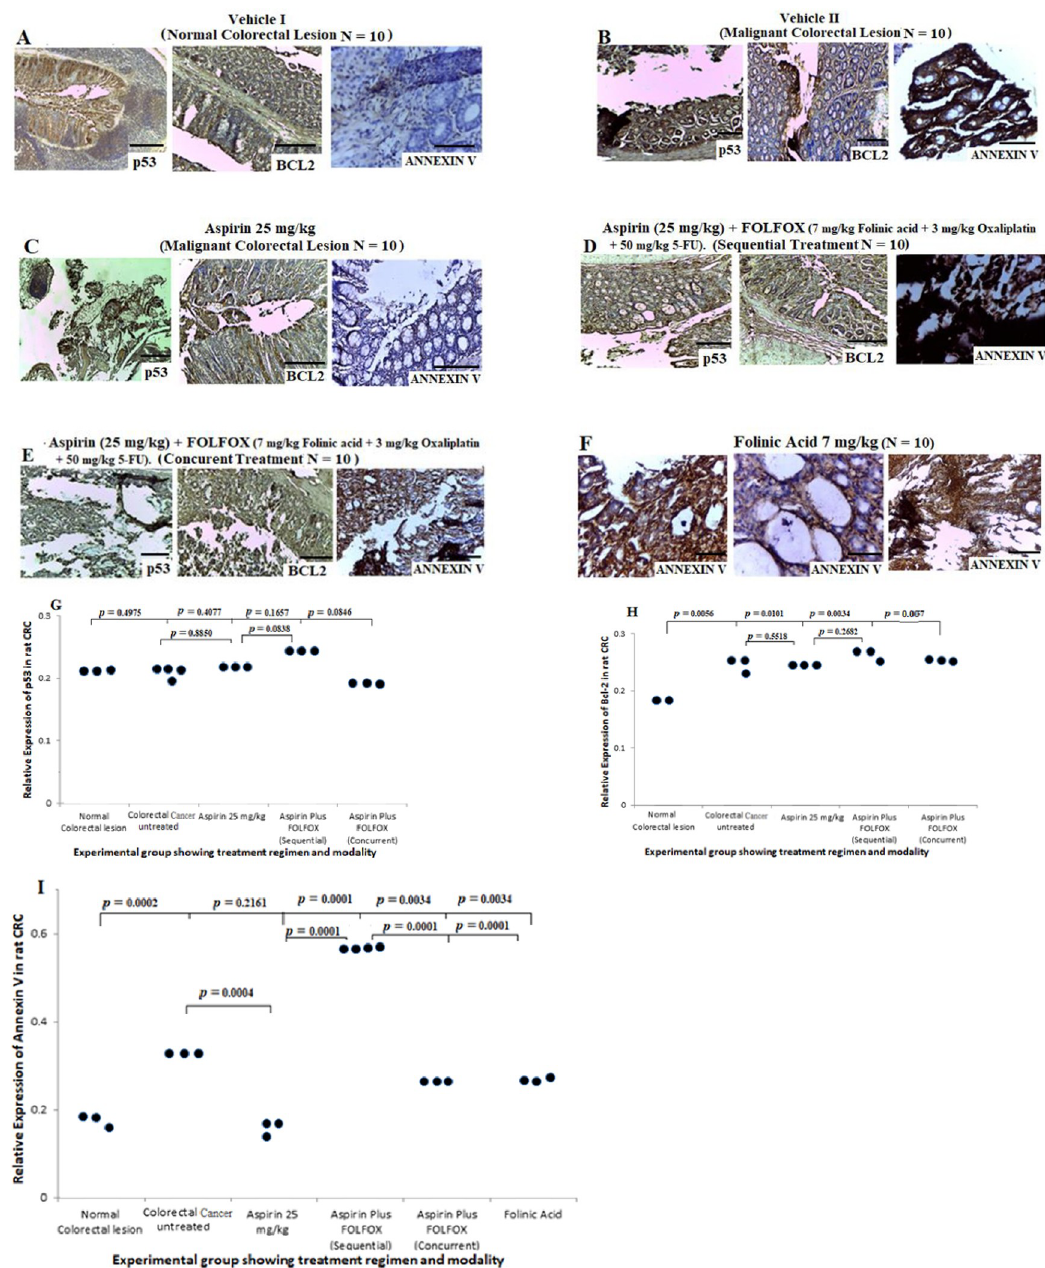
Fig 7. Prognostic significance of p53, Bcl-2 and Annexin V in colorectal cancer cells post-treatment with FOLFOX with or without aspirin in rat (scale bar = 50 μ m for H&E and scale bar = 100 μ m for IHC). A) Show positive expression of p53 and Bcl- 2 and negative expression of Annexin V in normal colorectal sections. B to F), Show positive expression of p53, Bcl-2 and Annexin V in colorectal cancer sections pre and post-treatment with 25 mg/kg aspirin, aspirin plus FOLFOX in sequence, aspirin plus FOLFOX concurrent, and folinic acid treatment. G to I) Quantitative analysis of the p53, Bcl-2 and Annexin V from the rats showing expression pattern typified in dot plot post and pre-treatment with aspirin and aspirin plus FOLFOX in various